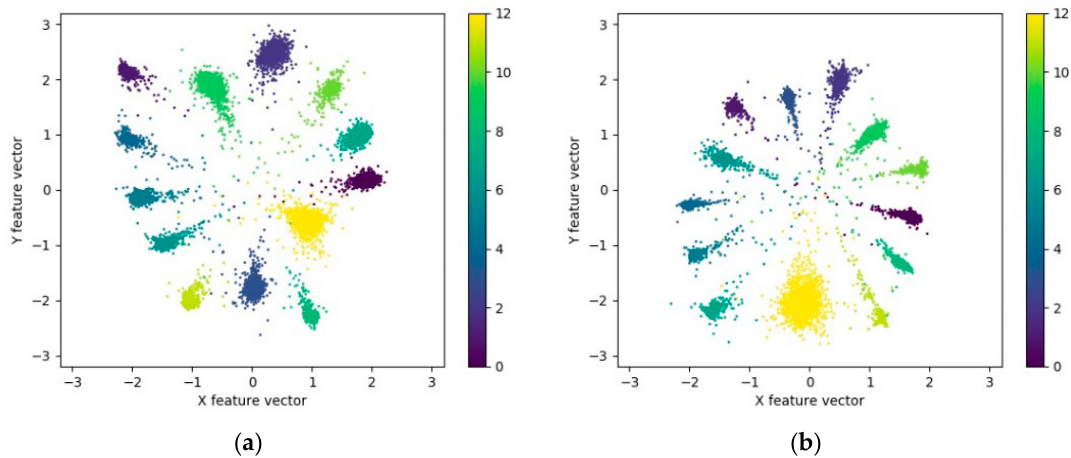
Figure 15. Visualization of the feature extracted by model B and C. ( a ) Model B; ( b ) Model C.